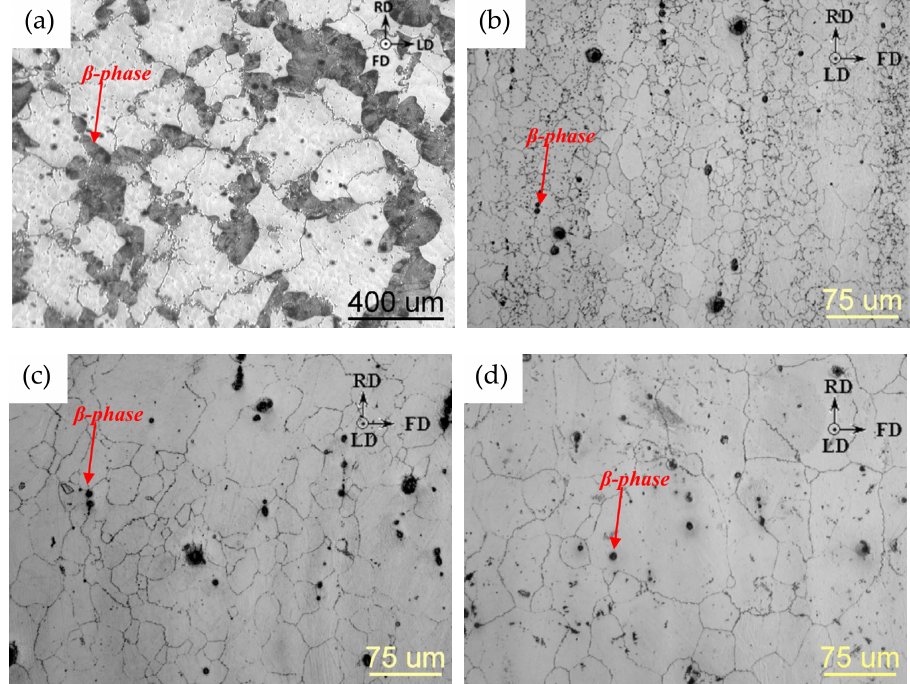
Figure 14. Microstructure of AZ80 in varying conditions: ( a )cast, ( b )forged into ‘flatbread’ samples at 350 ◦ C with 0.65mms − 1 , ( c )forged at 450 ◦ C with 0.65mms − 1 and ( d )forged at 450 ◦ C with 6.5mms − 1 [76]. Reproduced with permission from